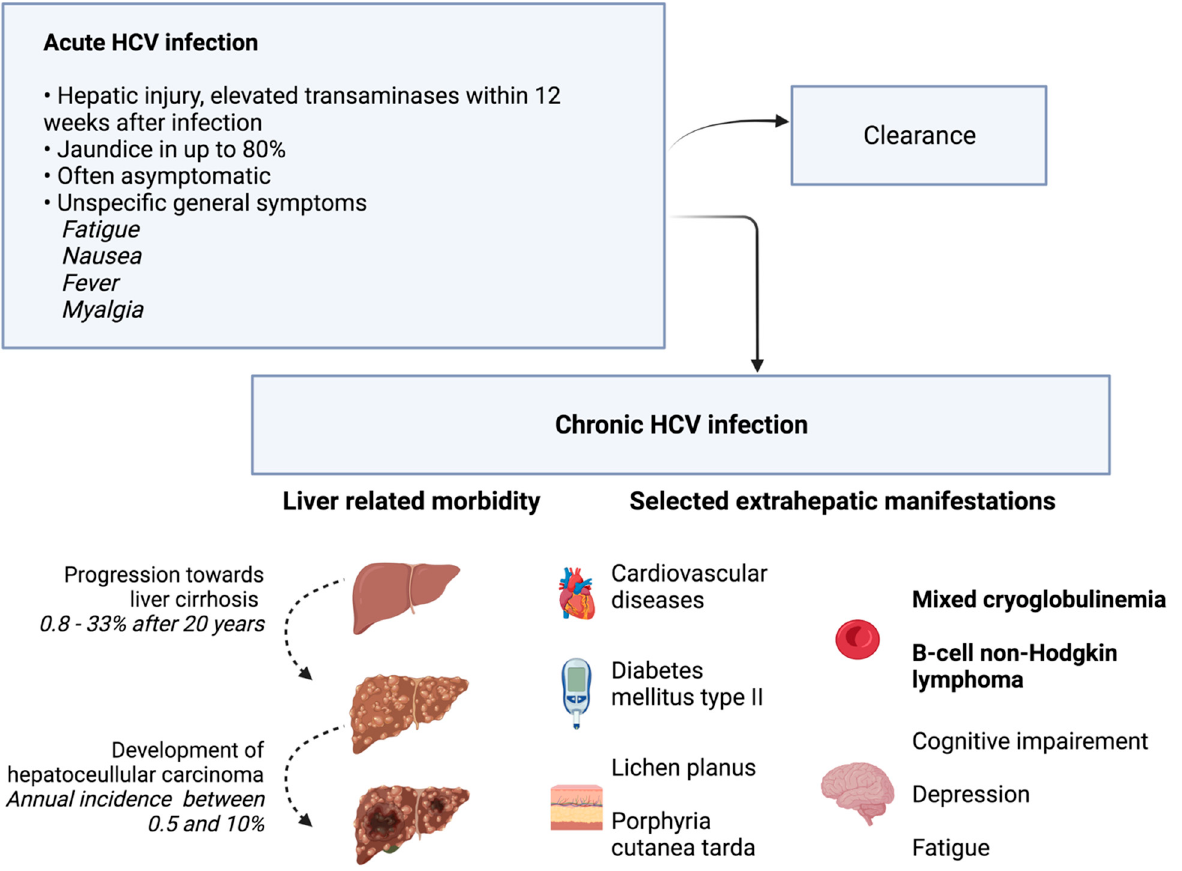
Figure 2. Clinical presentation and natural course of HCV infection. In addition to the acute and chronic clinical picture, selected extrahepatic manifestations are shown. Phenomena with the strongest evidence for association with chronic HCV infection are printed in bold font. The other phenomena were observed with higher prevalence in HCV-infected individuals than in controls, but evidence was less strong [9]. Additional references [7,8]. Created with BioRender.com.